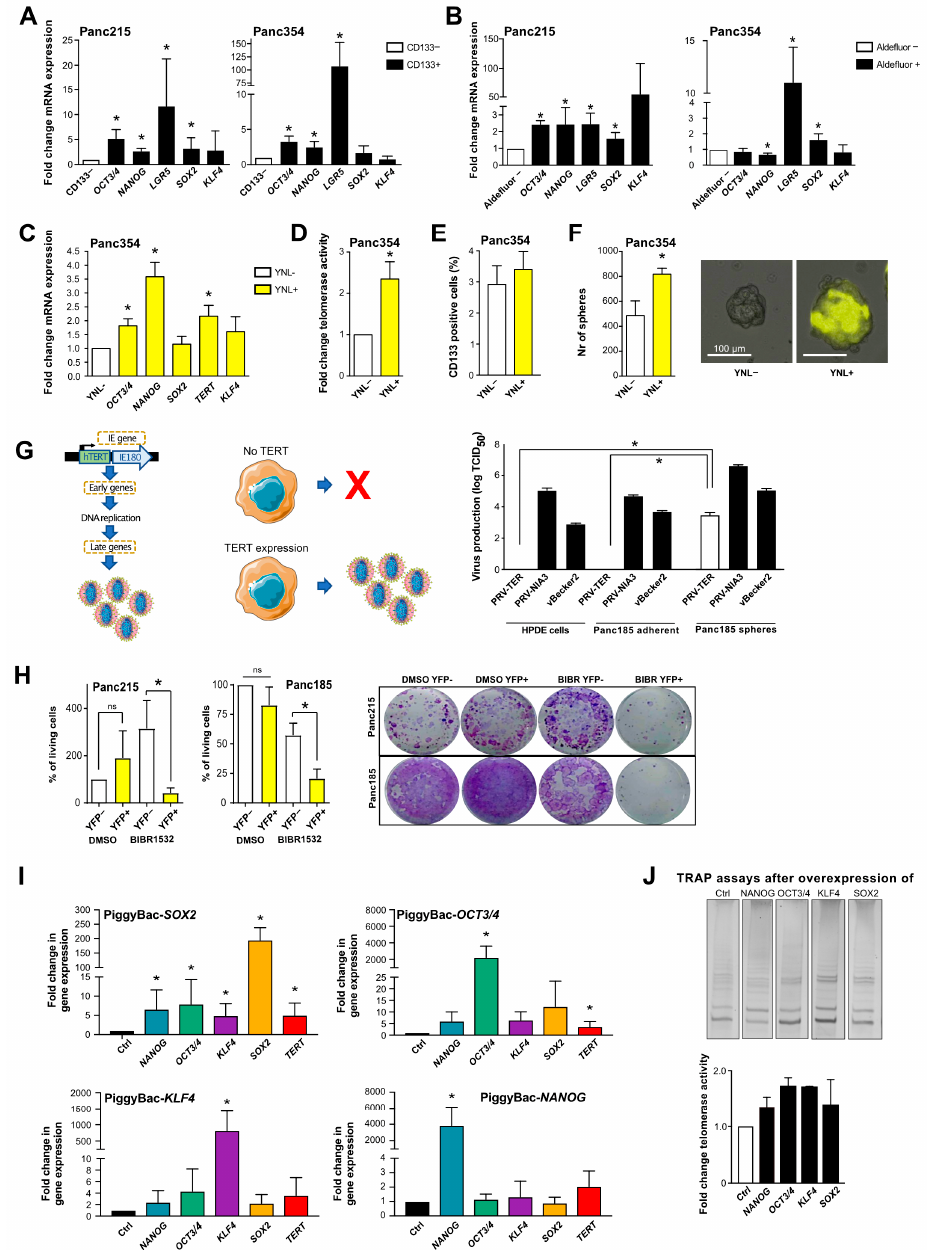
Figure 2. Interplay between pluripotency/stemness factors and telomerase activity in pancreatic CSCs: ( A , B ) RT-qPCR analysis of pluripotency/stemness-associated genes in primary pancreatic CSCs enriched by CD133 expression ( A ) or ALDE- FLUOR activity ( B ) vs. CD133 − and ALDEFLUOR- non-CSCs ( n = at least 3 independent FACSortings). ( C – F ) Quantitative RT-PCR ( C ), telomerase activity ( D ), flow cytometry analysis for CD133 ( E ) and sphere formation capability ( F ), compared in NANOG negative cells (white) vs. NANOG positive cells (yellow) using a NANOG-YNL reporter. ( G ) Schematic illustration and quantification on the production of virions in parental pseudorabies viruses (PRV-NIA3 and vBecker) compared to telomerase activity-dependent virus production (PRV-TER) in adherent HPDE and Panc185 cells as compared to Panc185 spheres. ( H ) Clonogenic Assay in NANOG-YNL positive and negative cells after withdrawing BIBR1532 ( n = ≥ 3 independent experiments. ns = not statistically significant) ( I ) Gene expression levels of stemness/pluripotency genes and TERT in HEK293T cells after inducing expression of SOX2, OCT3/4, KLF4 and NANOG , compared to the empty vector control ( n = 4 independent experiments). In ( A – I ), data are represented as mean ± SEM. * p ≤ 0.05 (Mann–Whitney-U test). ( J ) Telomerase activity after inducing expression of SOX2, OCT3/4, KLF4 and NANOG , compared to the empty vector control. Representative TRAP assays and quantification are